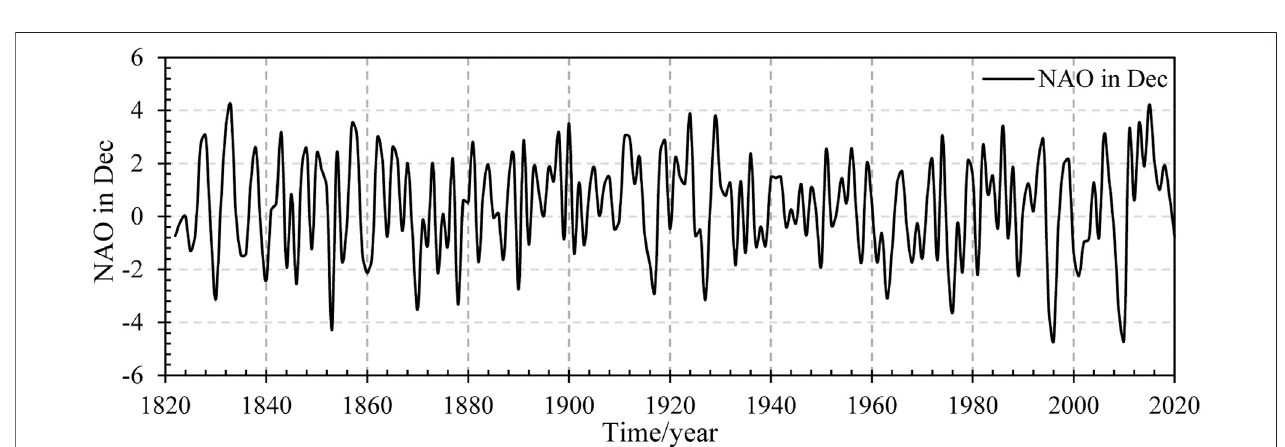
FIGURE 8 | North Atlantic Oscillation (NAO) in December (1822 – 2020).